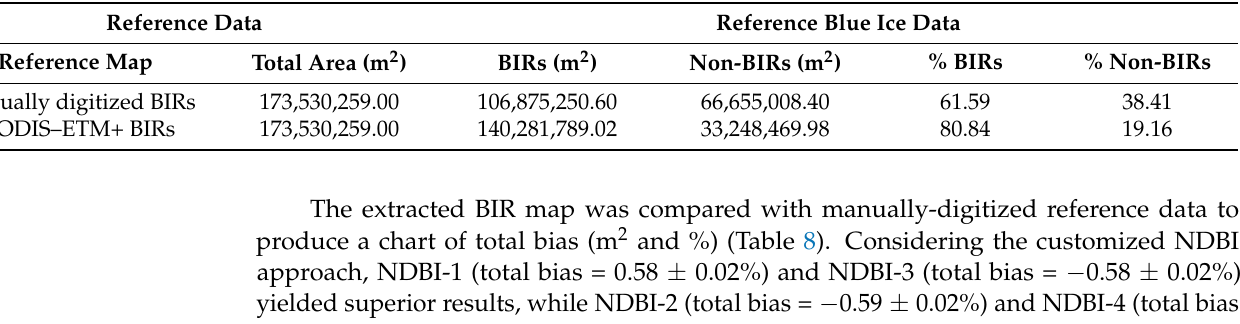
Table 7. Manually digitized data summarizing the reference blue ice regions (BIRs) and non-BIRs (snow/supraglacial debris, streams, etc.) for entire study area. The reference blue-ice area derived from existing MODIS/Landsat ETM+ [22] data is also